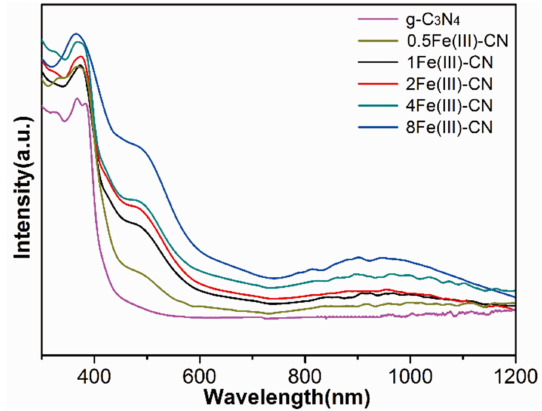
Figure 7. UV-Vis diffuse reflectance absorption spectra of all